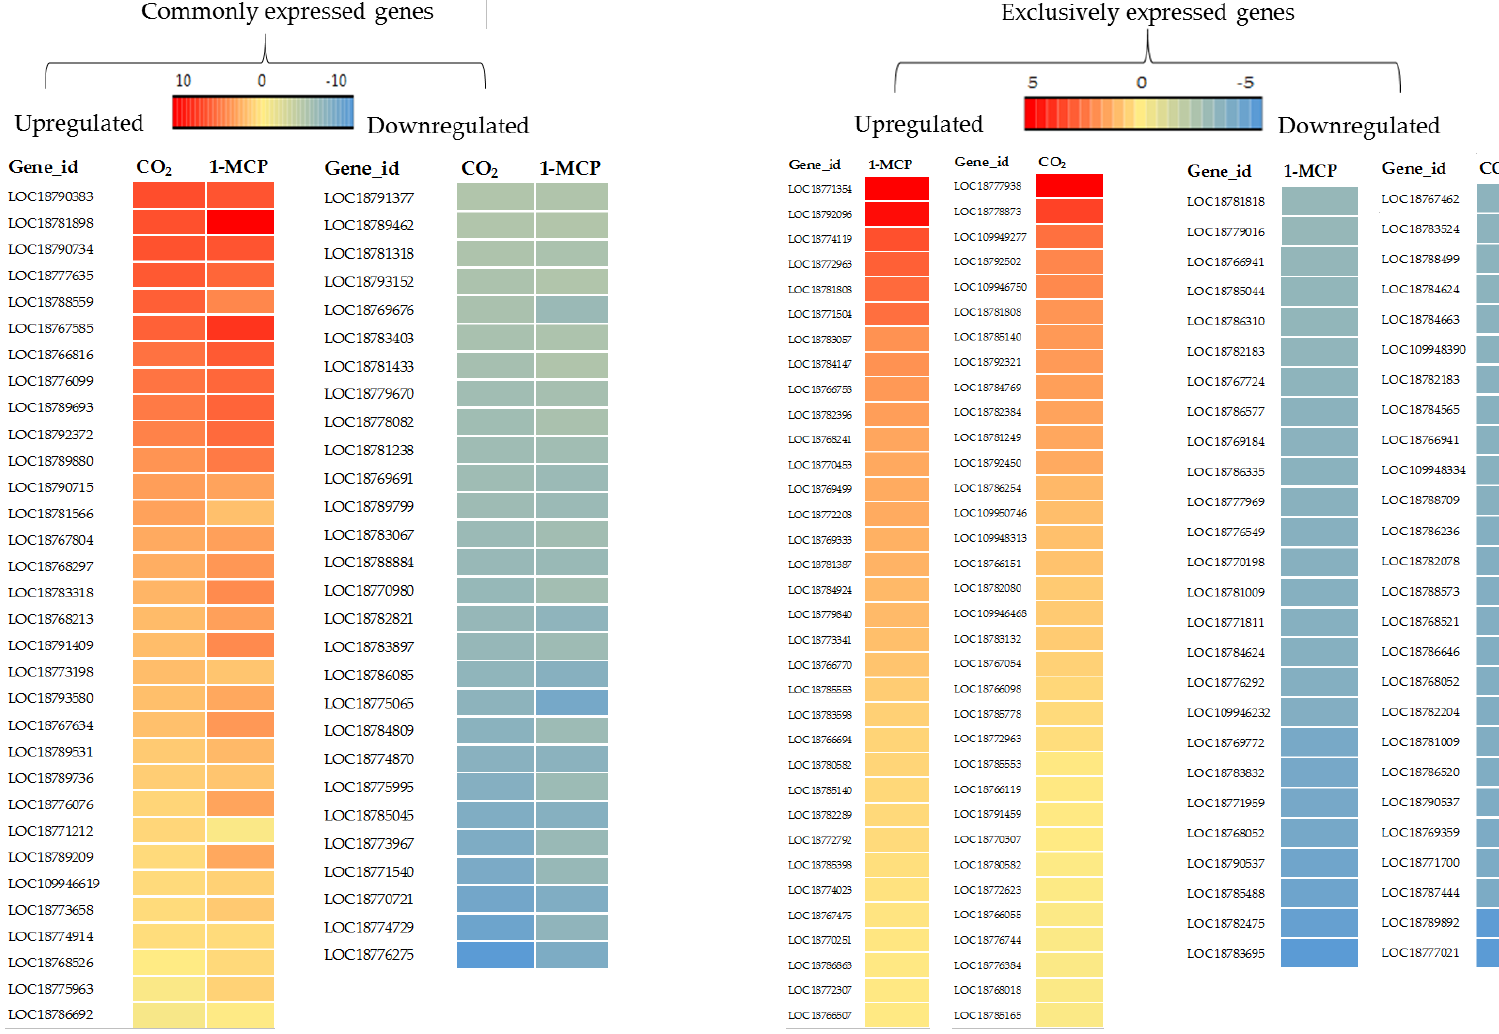
Figure 3. Heat map of commonly and exclusively expressed and identified DEGs in the comparison of CS vs. CO 2 +CS and 1-MCP+CS ‘Madoka’ peach fruit after 12 days storage.